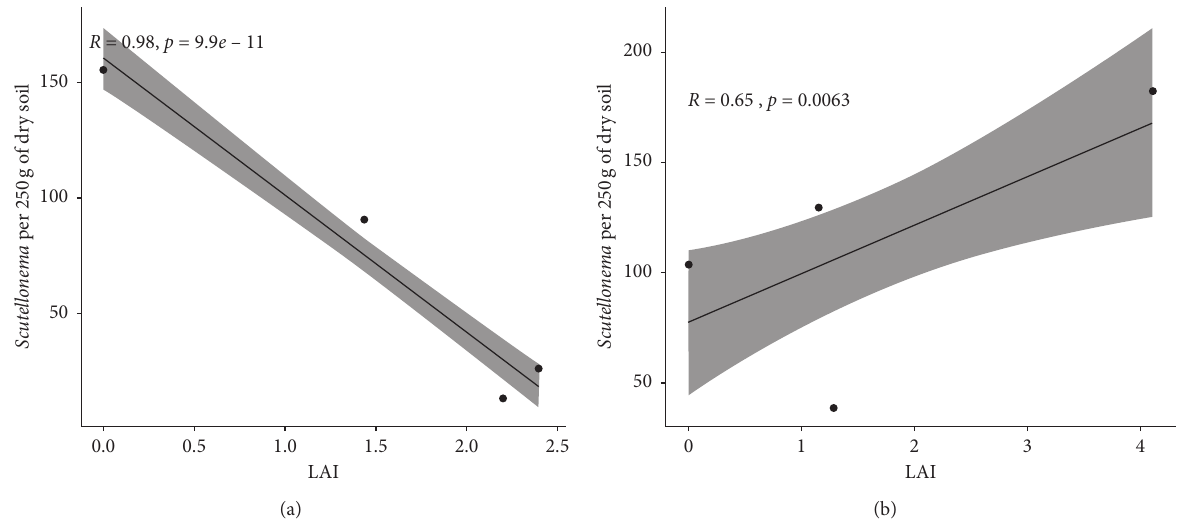
Figure 4: Correlation between leaf area index (LAI) and Scutellonema density during 2018 (a) and 2019 (b) in control plots. The relationship for 2018 showed a significant negative association ( R �− 0.98, p ≤ 0 . 001), while for 2019 it was positive ( R � 0.65, p < 0 . 05).